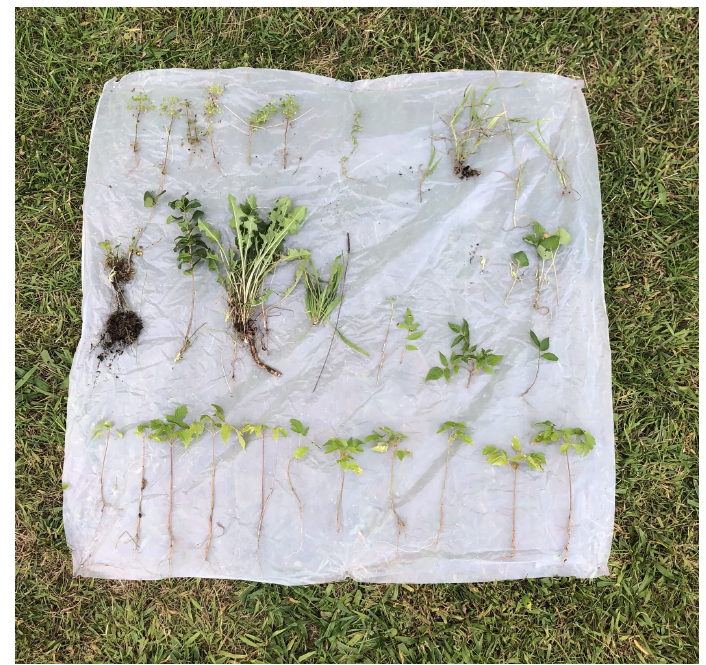
Figure 14: Plant species documented at Lawn Lab plot #10 on the day of redomestication in early September, including ( right to left, top to bottom ) slender yellow wood sorrel ( Oxalis dillenii ), prostrate knotweed ( Polygonum aviculare ), smooth crabgrass ( Digitaria ischaemum ), common buckthorn ( Rhamnus cathartica) , dandelion ( Taraxacum officinale ), buckhorn plantain ( Plantago lanceolata ), eastern black walnut ( Juglans nigra ), tree of heaven ( Ailanthus altissima ), common blue violet ( Viola sororia ), Siberian elm ( Ulmus pumila ), and eleven box elder ( Acer negundo ) seedlings in the bottom row. Species documented in the plot but not pictured here include white clover ( Trifolium repens ), black medic ( Medicago lupulina ), corn speedwell ( Veronica arvensis ), and a mysterious conifer seedling that was likely dug up by a visiting skunk before it could be